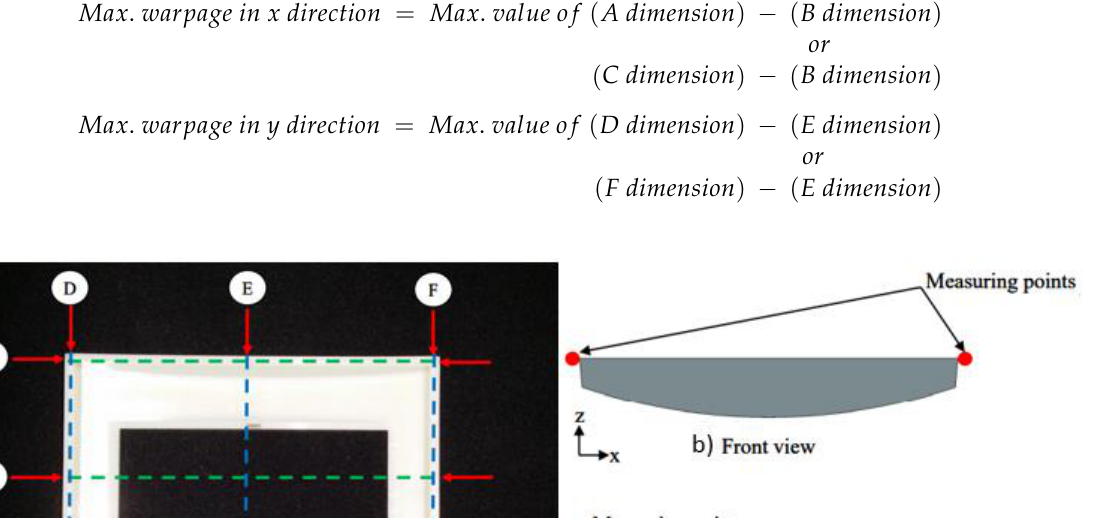
Table 8. Average warpage results on the front panel housing based on experimental works for both straight drilled and MGSS conformal cooling channels.